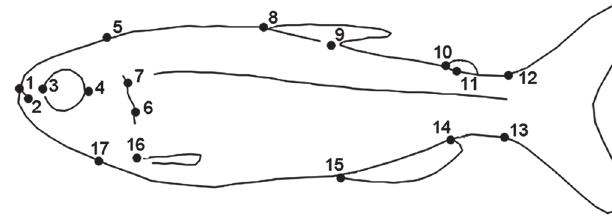
Fig. 2. Anatomical landmarks selected for morphometric analysis: 1:Snout tip; 2: Posterior region of premaxilla; 3: Anterior margin of eye; 4: Posterior margin of eye; 5: Dorsal region of head; 6: Lower curve of opercle; 7: Upper curve of opercle; 8: Anterior insertion of dorsal fin; 9: Posterior insertion of dorsal fin; 10: Anterior insertion of adipose fin; 11: Posterior insertion of adipose fin; 12: Dorsal beginning of caudal fin; 13: Ventral beginning of caudal fin; 14: Posterior insertion of anal fin; 15: Anterior insertion of anal fin; 16: Insertion of pectoral fin; 17: Ventral region of